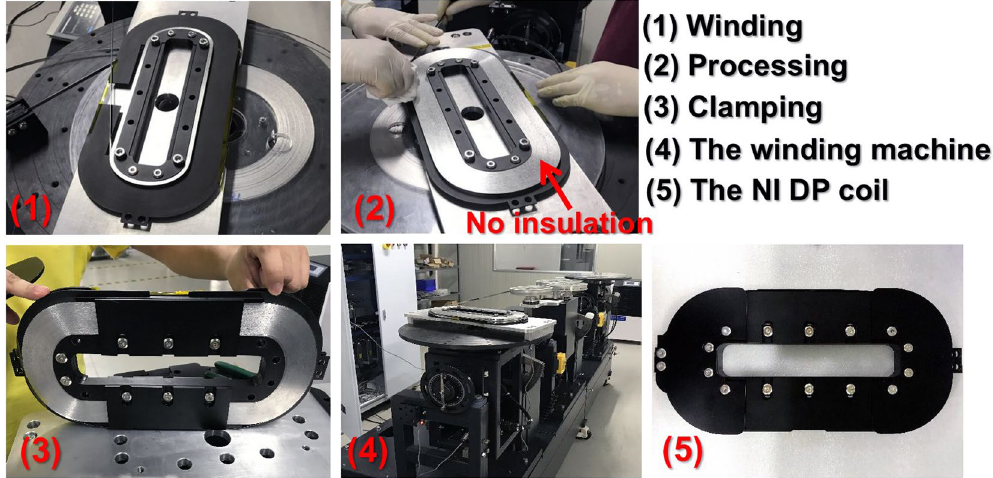
Figure 5. Manufacture of a 300-turn NI DP coil. The bobbin is made of high thermal conductivity aluminum alloy 6063-T5 with hard anodizing surface treatment for formation of thin (~70 μ m) but reliable insulations.